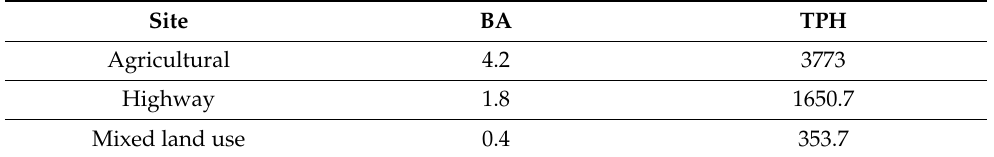
Table 3. Vegetation data from the tree plots per site that were located right along the woodlot’s